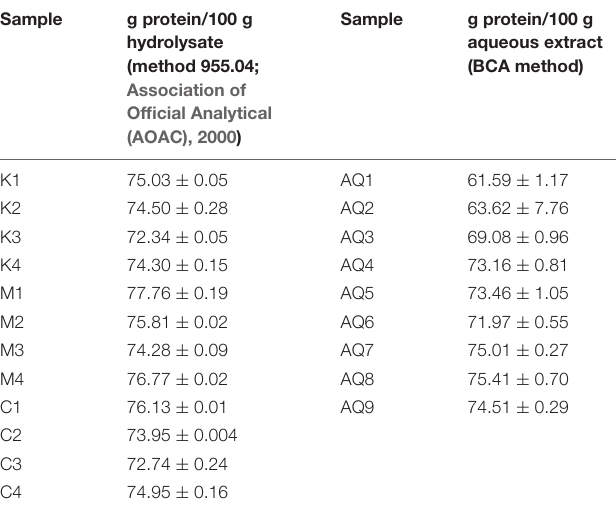
TABLE 1 | Protein content of mesopelagic Hydrolysates and aqueous extracts ( n = 3).